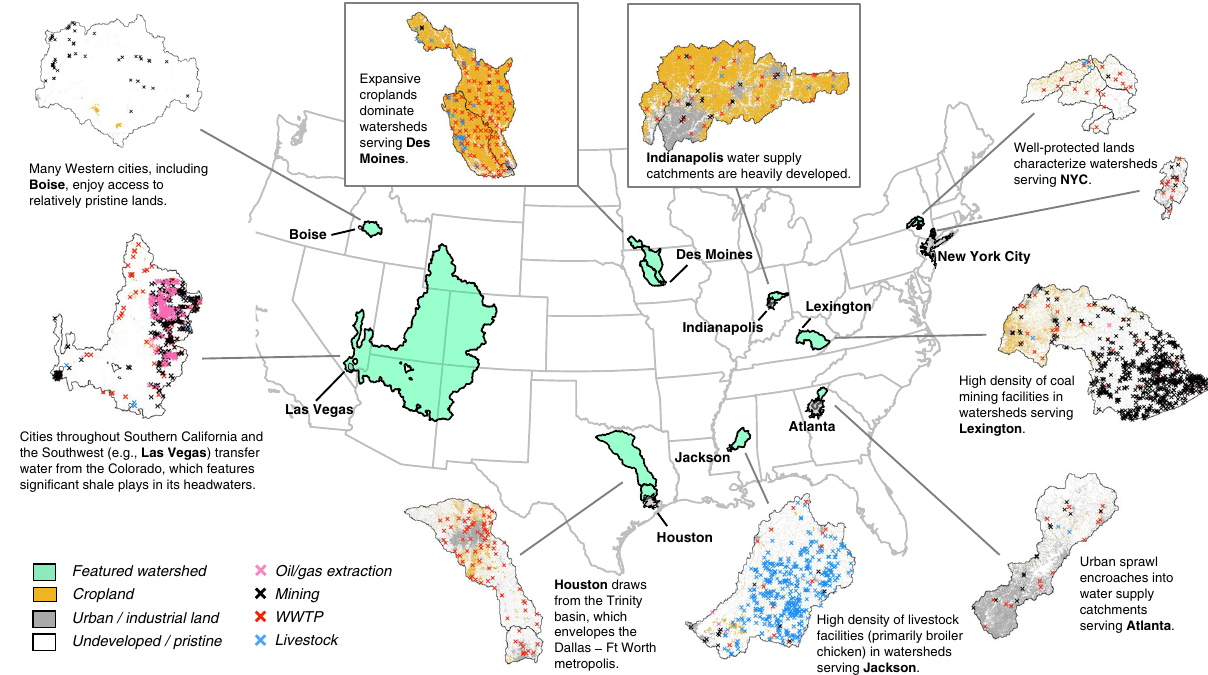
Fig. 2 Diverse land use and anthropogenic activities across urban source watersheds. Select cities and their associated source watersheds, showing the diversity of primary land use and anthropogenic drivers of potential contamination across the